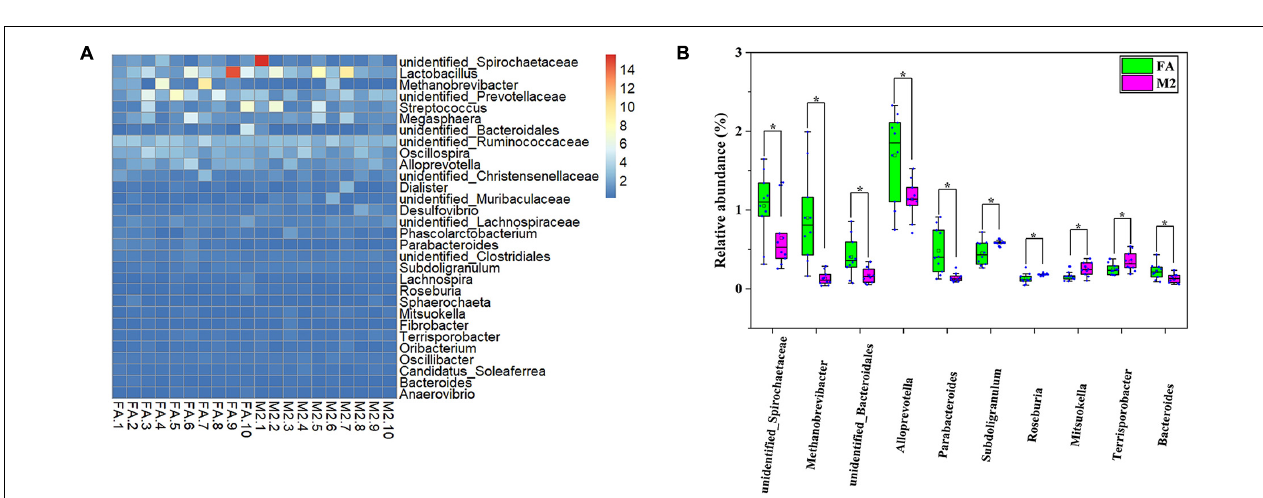
FIGURE 2 | Generic differences between FA and M2 groups. (A) Heat map of the relative abundance of top 30 genera. (B) Significantly different genera in feces between FA and M2 groups. FA, pigs had free access to feed; M2, pigs were given two meals per day (0800 and 1800 h); each meal lasted 60 min. * p < 0.05.